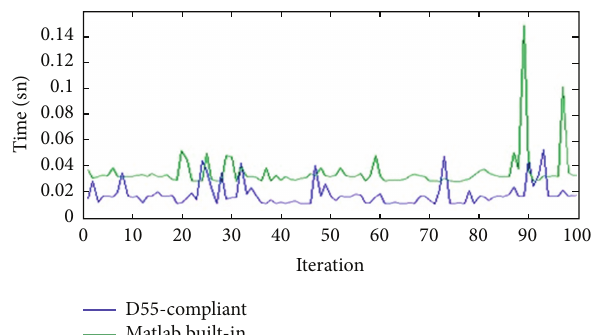
Figure 9: Comparison of processing time at Matlab built-in and D55-compliant software at 100 iterations.